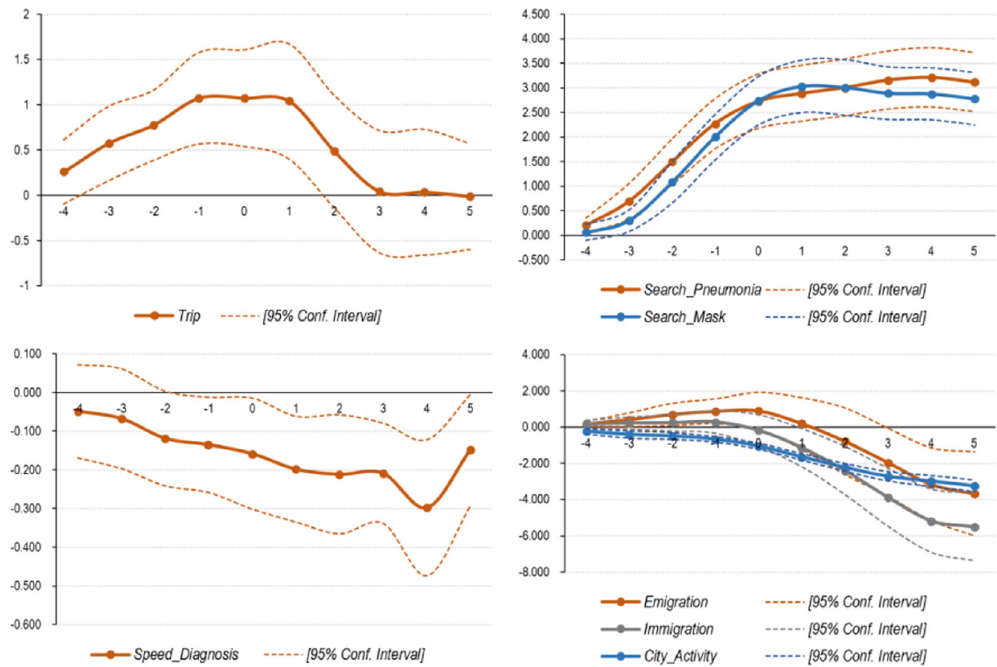
Fig. 3 Behaviors of the infected and the susceptible around the entry into a government disclosure regime. In a 11-day window [ − 5, 5] around the entry into a government disclosure regime, we estimate regression Eqs. (1 – 4) replacing Post with indicators Day − 4, Day − 3, … , Day 4 and Day 5 indicating days relative to the entry into the disclosure regime. The coef fi cients and con fi dence intervals for these indicators are plotted